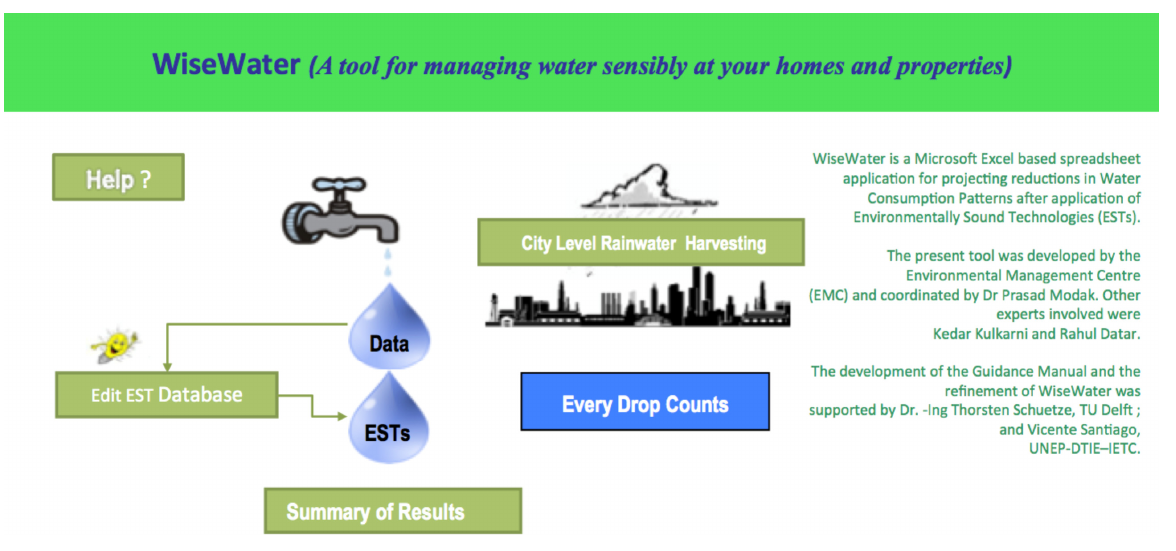
Figure 5. User Interface of the Microsoft Excel based software tool “Wise